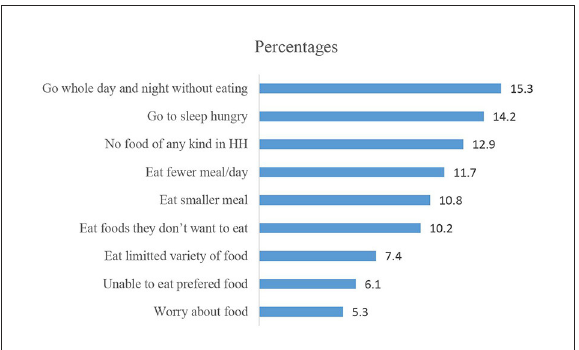
FIGURE1 Distribution of household food insecurity based on the HIFAS scale among pregnant women attending ANC in East Shao zone, Ethiopia, from June to August 2021.